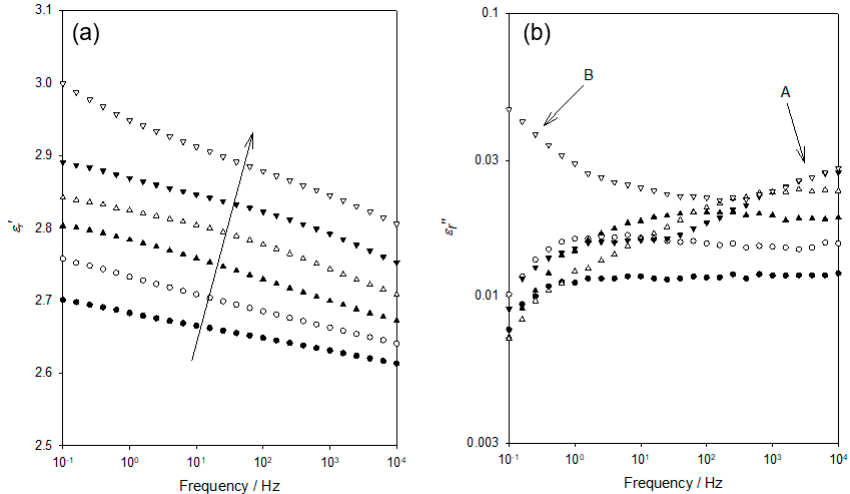
Figure 3. Dielectric data acquired at temperatures of 103 K ( • ), 123 K (o), 143 K ( (cid:78) ), 163 K ( (cid:52) ), 183 K ( (cid:72) ), and 203 K ( (cid:53) ): ( a ) frequency dependence of the real part of the relative permittivity, ε r (cid:48) ; ( b ) frequency dependence of the imaginary part of the relative permittivity, ε r ”.